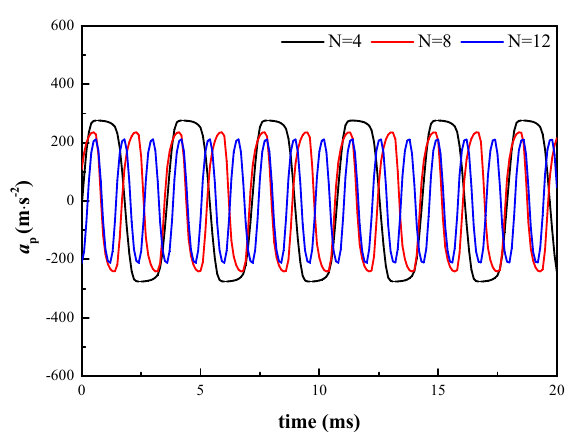
Figure 18. Velocities of different orifice numbers.